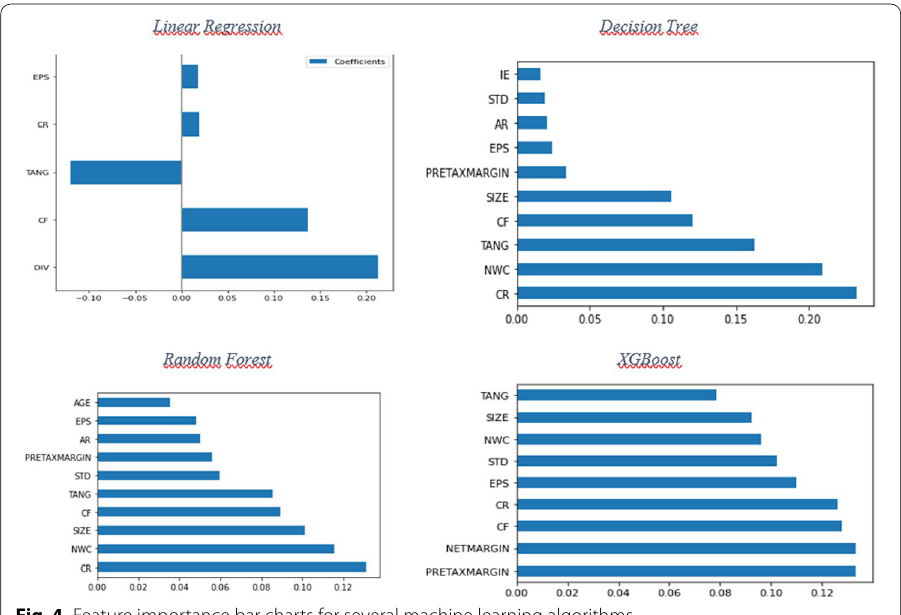
Fig. 4 Feature importance bar charts for several machine learning algorithms